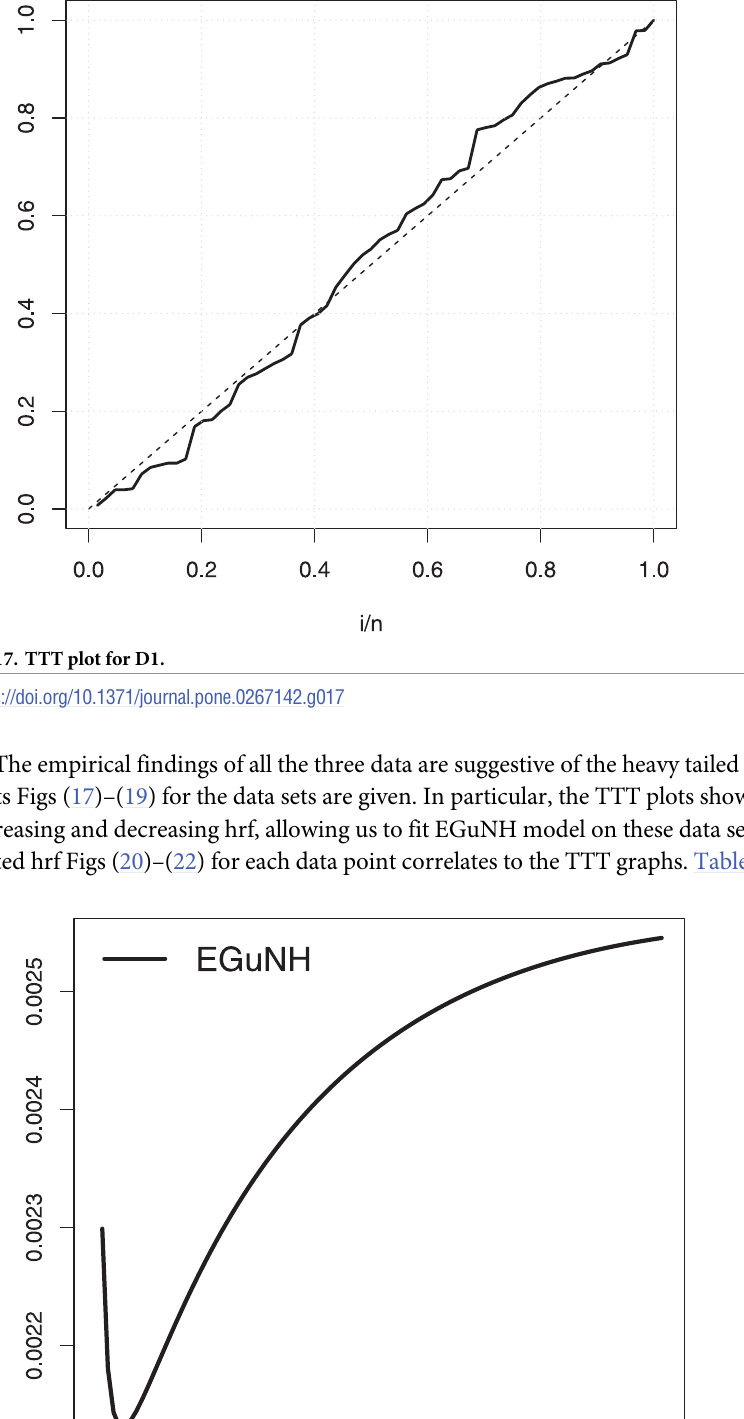
Fig 18. TTT plot for D2.